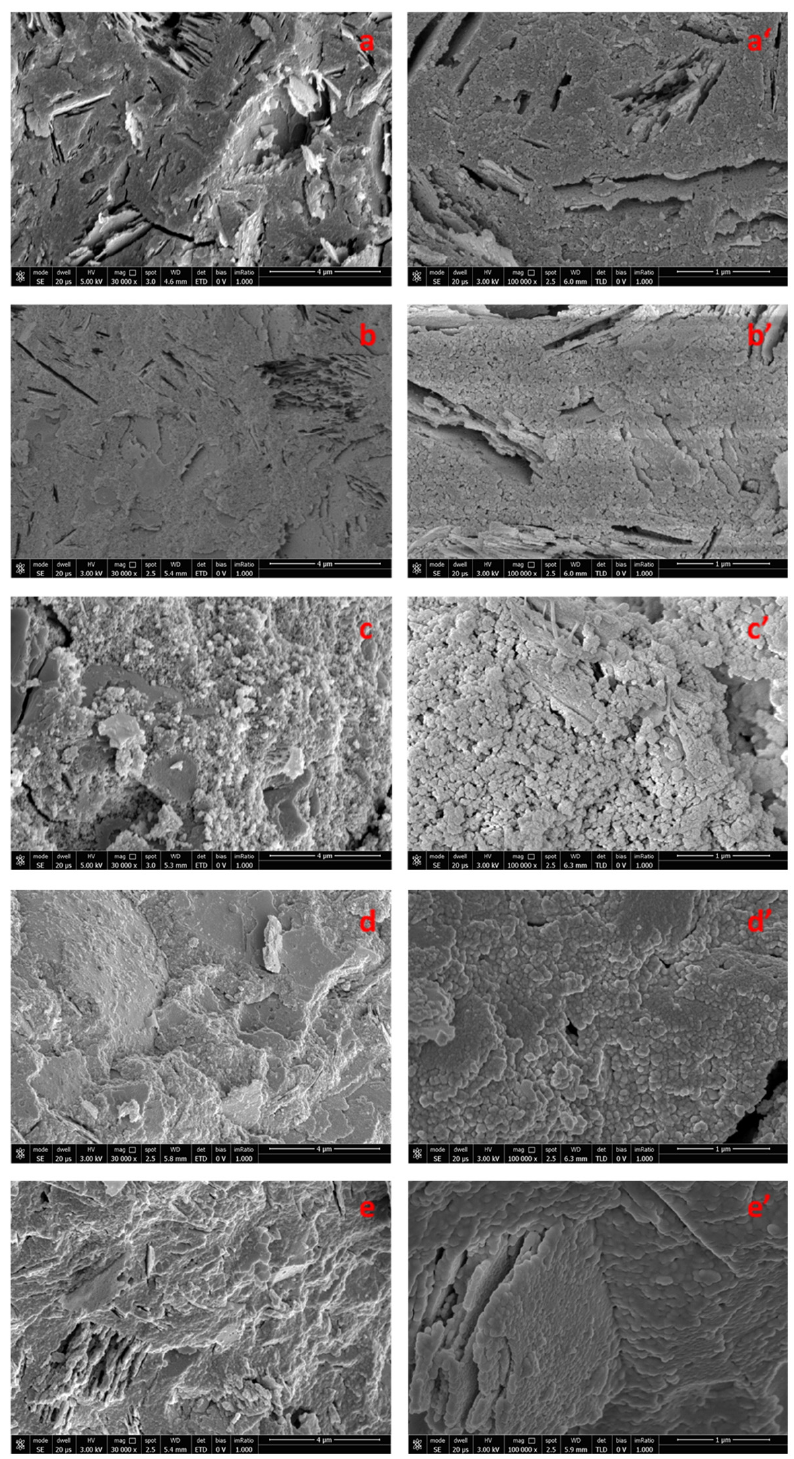
Figure 3. Scanning electron microscope (SEM) micrographs at 30,000 × and 100,000 × magnifications of freshly obtained fractured surfaces of: neat geopolymer MK ( a , a’ ), MK-PVAc-5 ( b , b’ ), MK- PVAc- 10 ( c , c’ ), MK-PDMS-5 ( d , d’ ), and MK-PDMS-10 ( e , e’ ).